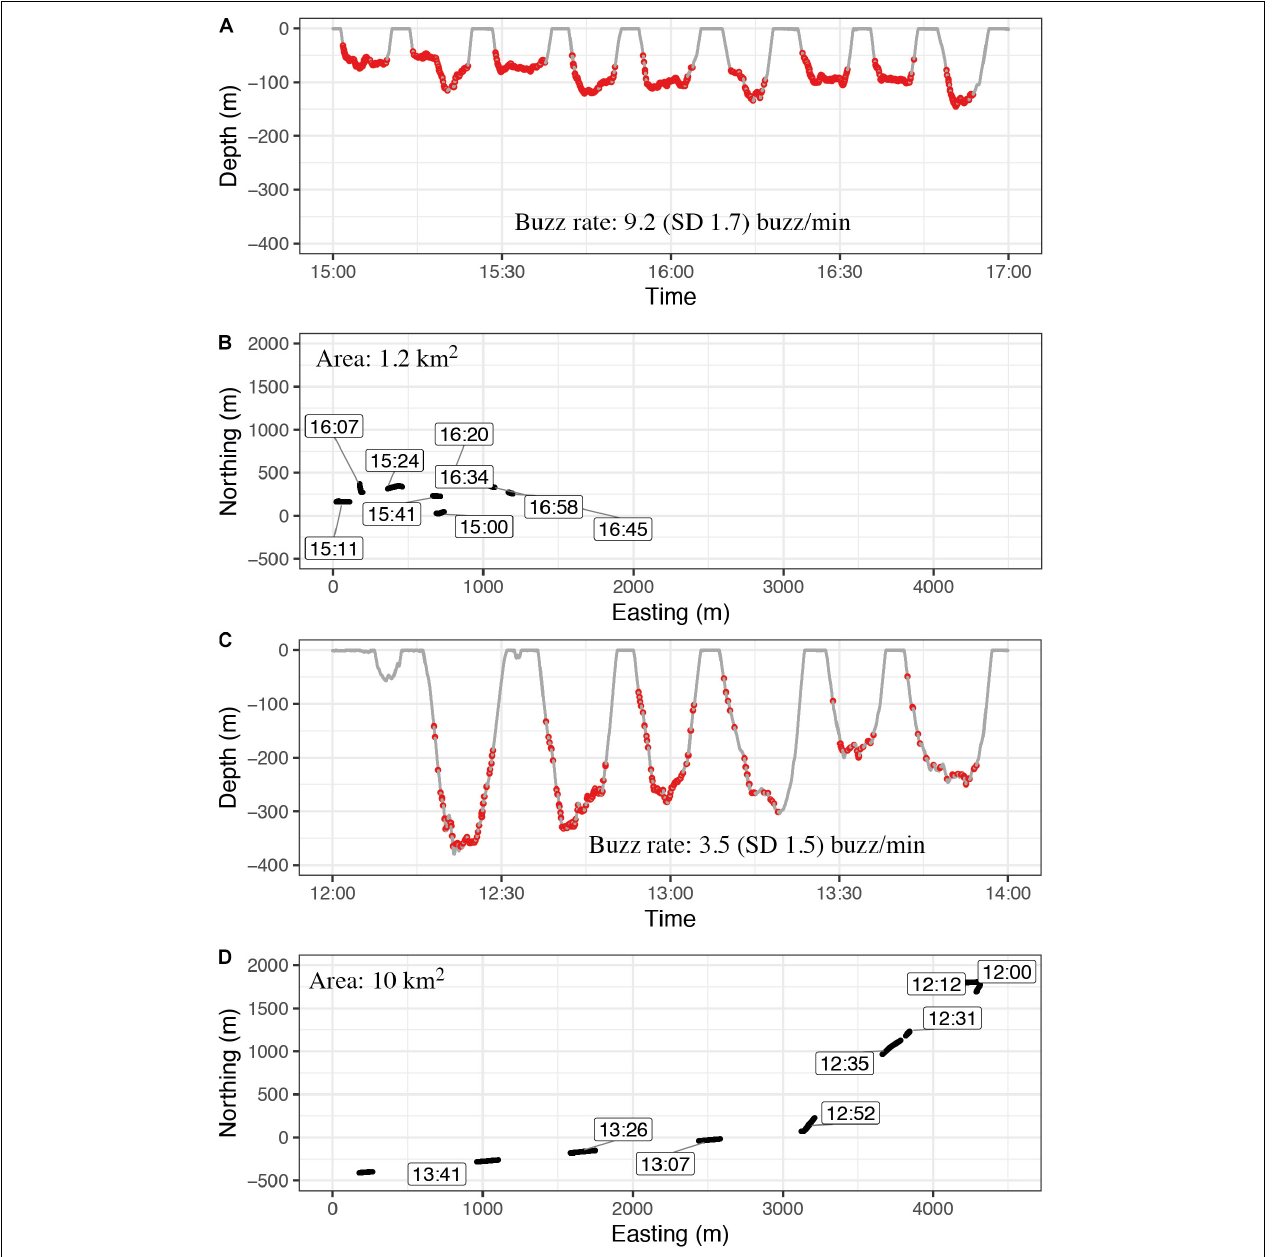
FIGURE 7 | Examples of diving and buzzing behavior while the animal is circling a small area (stationary foraging category) (A,B) and foraging while transiting through a larger area in a fast and directed manner (C,D) . All windows have a length of 2 h. Buzzing rate was calculated for the duration from the first buzz to the last buzz per dive. The average buzzing rate during stationary foraging events (A,B) was on average double as high as during transient foraging (C,D) ( Table 4 ). These examples are sections from stationary phase with rank 4 and transit phase with rank 10 from individual 2017MM3 ( Supplementary Table S2